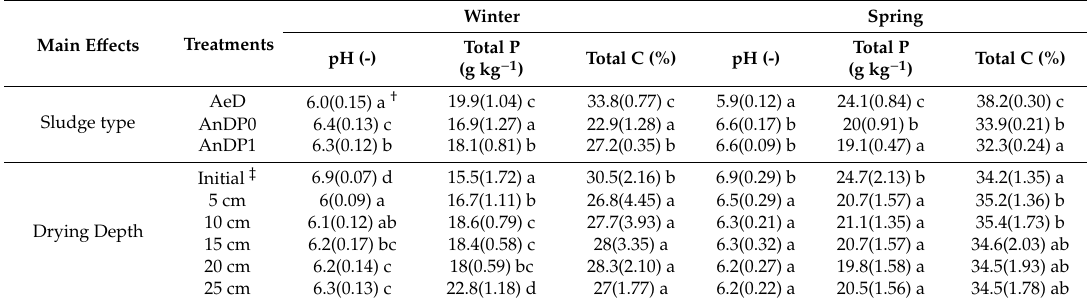
Table 3. Main e ff ects of sludge type and drying depths pH, total P, and total C during sludge drying in winter and